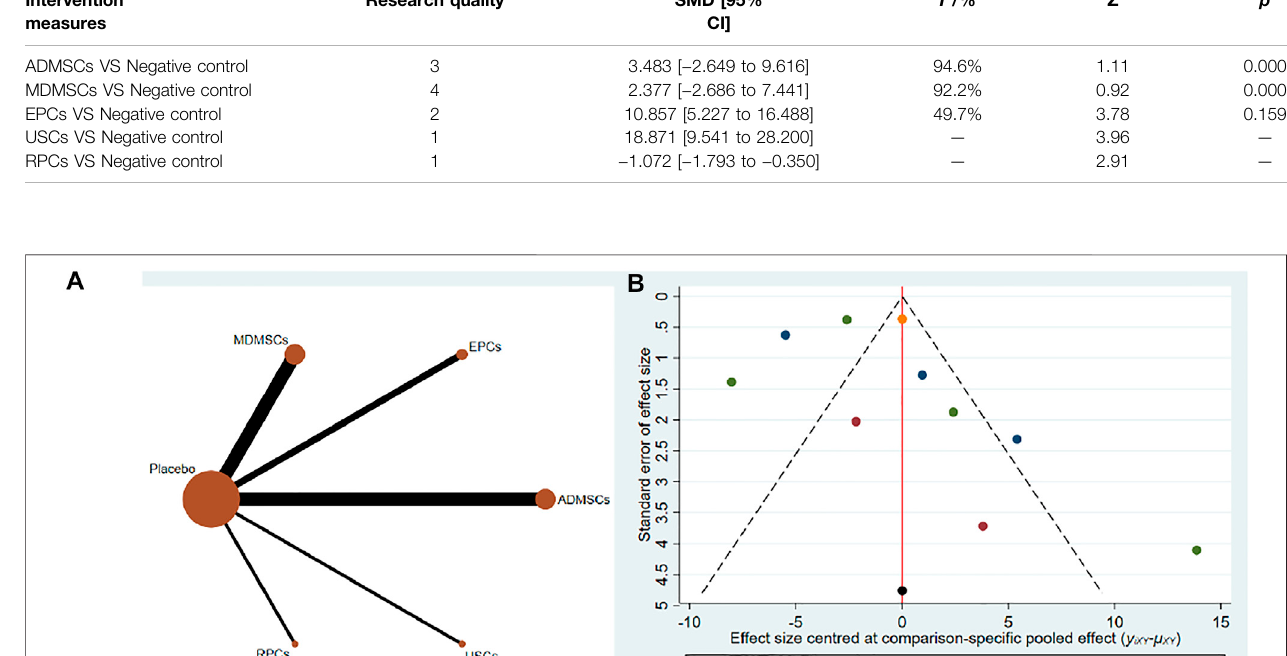
TABLE 12 | Network Meta-analysis results of blood urea nitrogen levels in stem cell groups at 14 days after administration.